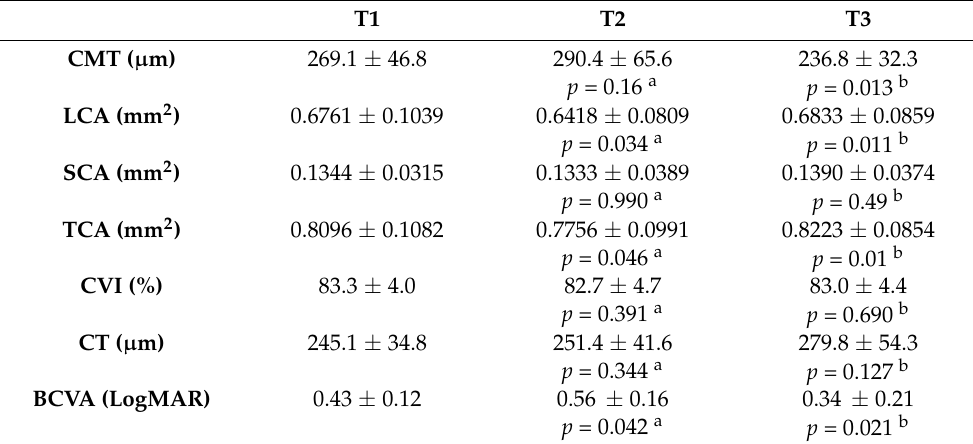
Table 2. Structural OCT variables and BCVA changes tested at T1, T2, and T3.